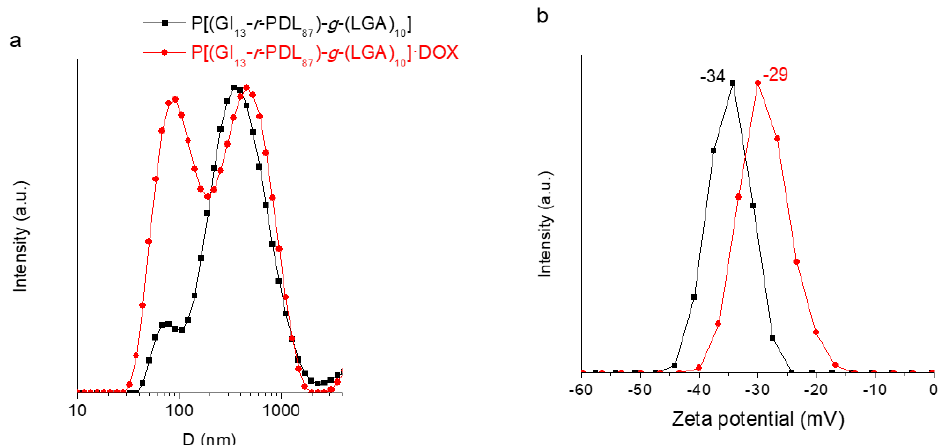
Figure 8. DLS profiles ( a ) and zeta potential ( b ) of the P[(Gl 13 - r -PDL 87 )– g –(LGA) 10 ] copolymer and the P[(Gl 13 - r -PDL 87 )– g –(LGA) 10 ] · doxorubicin (DOX) conjugate.